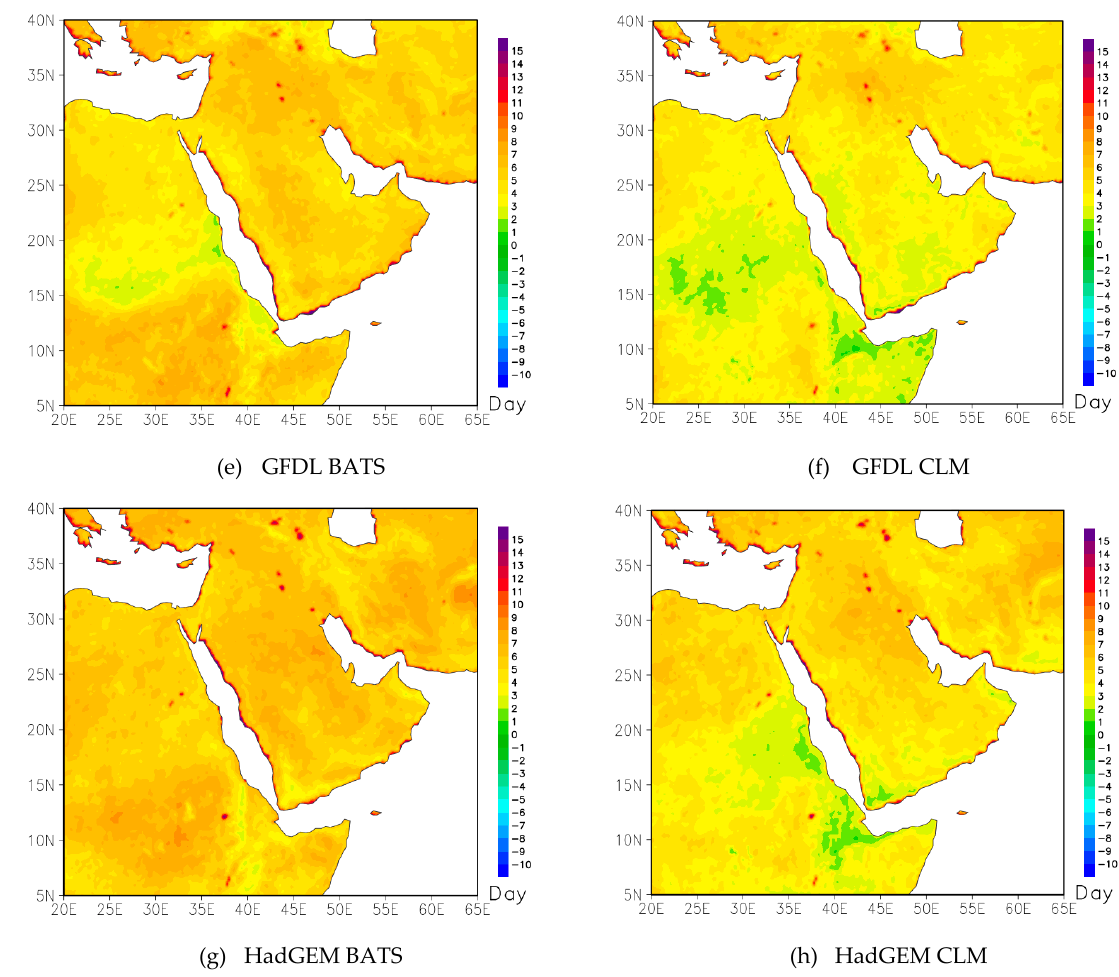
Figure 8. Spatial distribution of annual warm spell duration index (WSDI) for ( a ) ERA–Int BATS, ( b ) ERA–Int CLM, ( c ) ECHAM6 BATS, ( d ) ECHAM6 CLM, ( e ) GFDL BATS, ( f ) GFDL CLM, ( g ) HadGEM